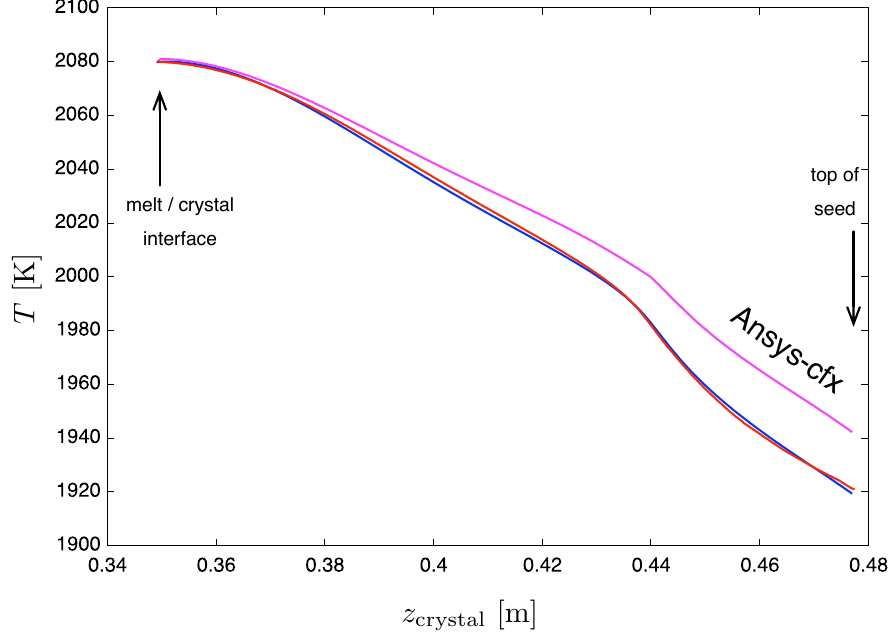
Figure 4. Temperature profile for Case 1 along the axis for runs with three different software tools. The curve in magenta is from the Ansys-cfx run (3D calculation). The temperature at the top is higher because we used the boundary conditions from a CrysMAS run without melt convection. The red and blue curves are the results of the runs with CGsim and CrysMAS,